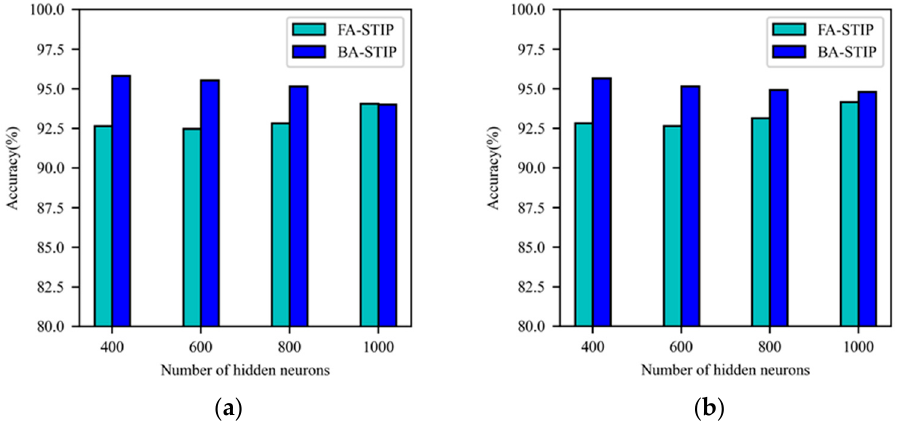
Figure 7. Comparison of learning performance for three STIP ‐ based algorithms with inverse multi ‐ quadratic kernel function. ( a ) The accuracy of the training set; ( b ) the accuracy of the testing set. Figure 8. Comparison of learning performance for three STIP ‐ based algorithms with α‐ kernel func ‐ tion. ( a ) The accuracy of the training set; ( b ) the accuracy of the testing set.